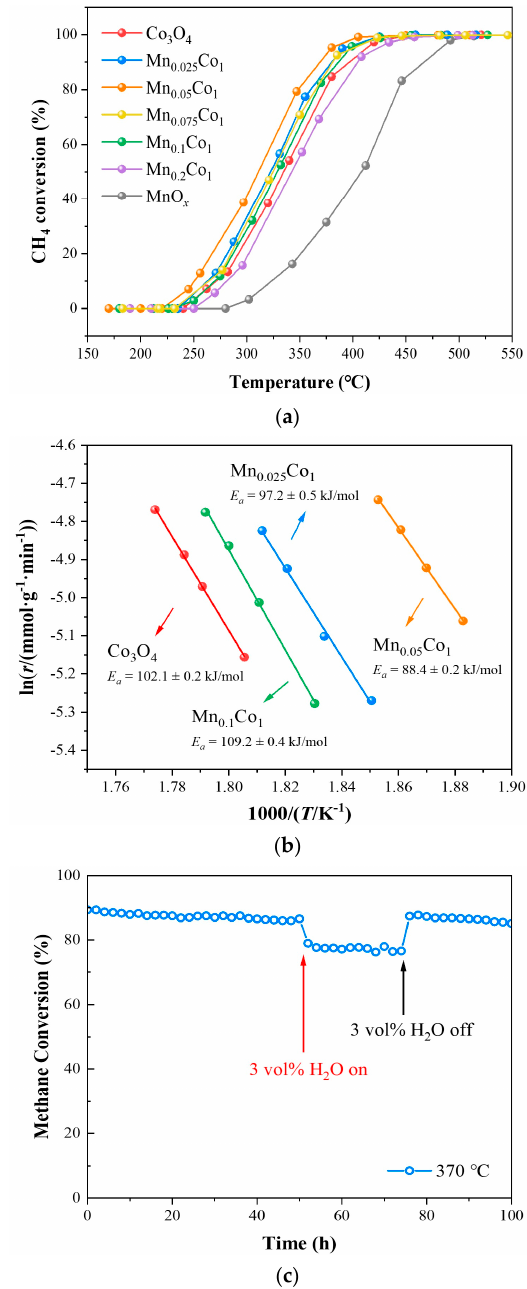
Figure 6. ( a ) Catalytic activities of the Co 3 O 4 , Mn-doped Co 3 O 4 , and MnO x samples. ( b ) Arrhenius plots of the CH 4 oxidation rates over the Co 3 O 4 and Mn x Co 1 ( x = 0.025, 0.05, 0.1) catalysts. ( c ) Stability test and effect of 3 vol% steam on CH 4 conversion over the Mn 0.05 Co 1 catalyst at 370 °C. Reaction conditions: 0.5 vol% CH 4 , 20 vol% O 2 , N 2 as the balance gas. GHSV = 12,000 mL g − 1 h − 1 . To compare the catalytic activity differences of the samples more clearly, the temper- atures needed for 10%, 50%, and 90% CH 4 conversion ( T 10 , T 50 , and T 90 ) of all the catalysts